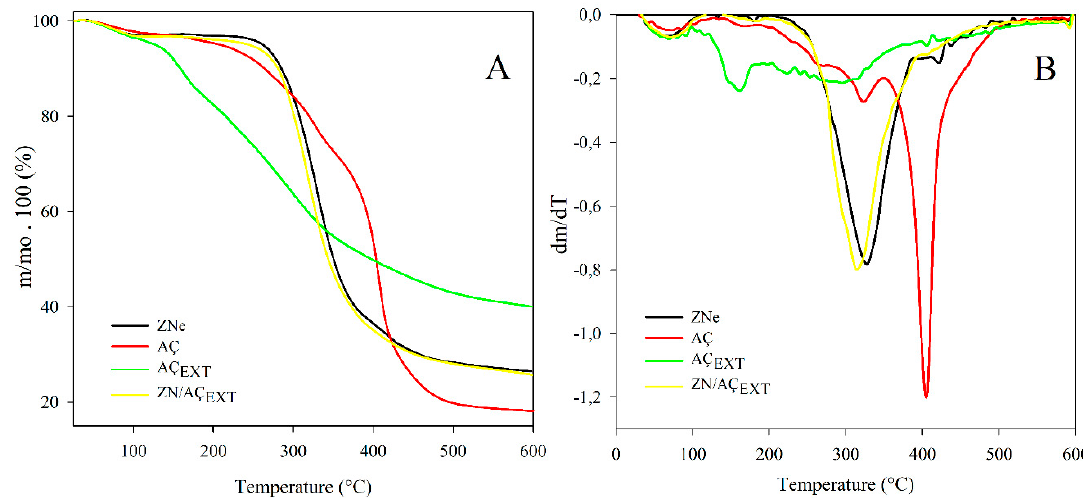
Figure 3. ( A ) Weight loss; and ( B ) derivative of the weight loss of electrosprayed zein (Zne), dried açaí fruit (AÇ), lyophilized açaí fruit extract (AÇ EXT ), electrosprayed zein capsules containing açaí (ZN/AÇ EXT ).